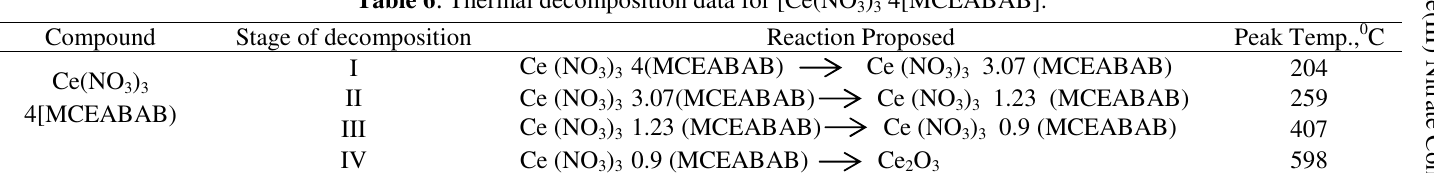
Table 6 . Thermal decomposition data for [Ce(NO